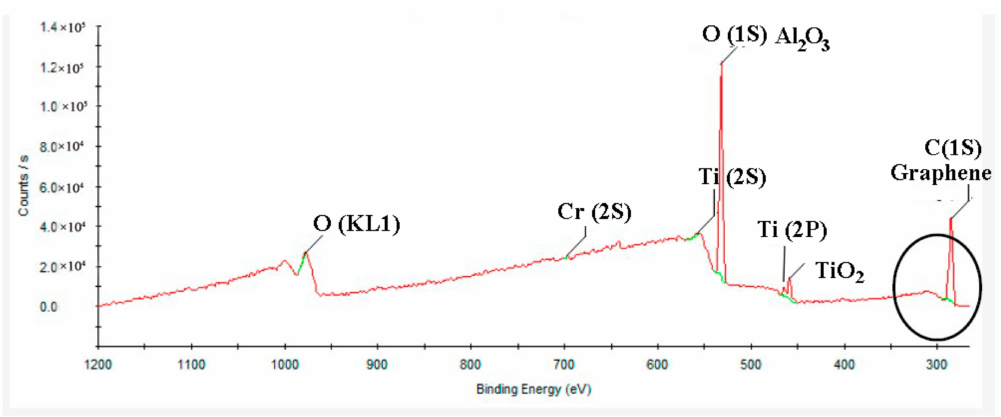
Figure 3. X-ray photoelectron spectroscopy (XPS) diagram of the GO-coated TiAl powders milled by the PVA-modified specimen.